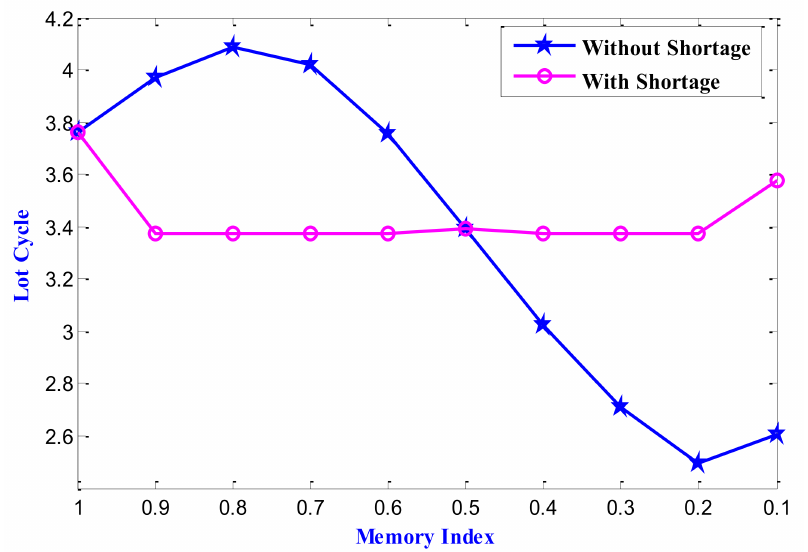
Figure 4. Impact memory on optimum values of the decision variable lot cycle (Q ∗ ) for the model with and without shortage (from left to right in the horizontal axis memory sense increases).